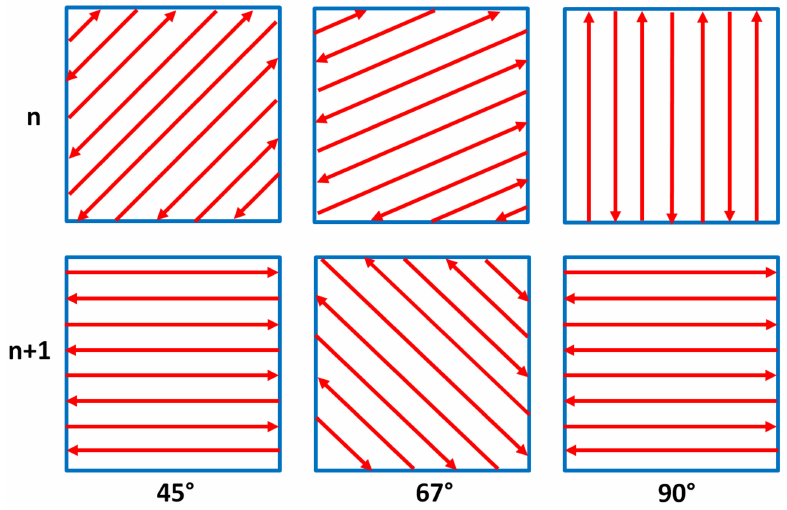
Figure 1. Hatch angles used for manufacturing the IN 625